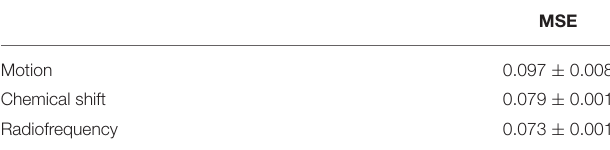
TABLE 5 | MSE loss per class for severity regression CNN (mean ±